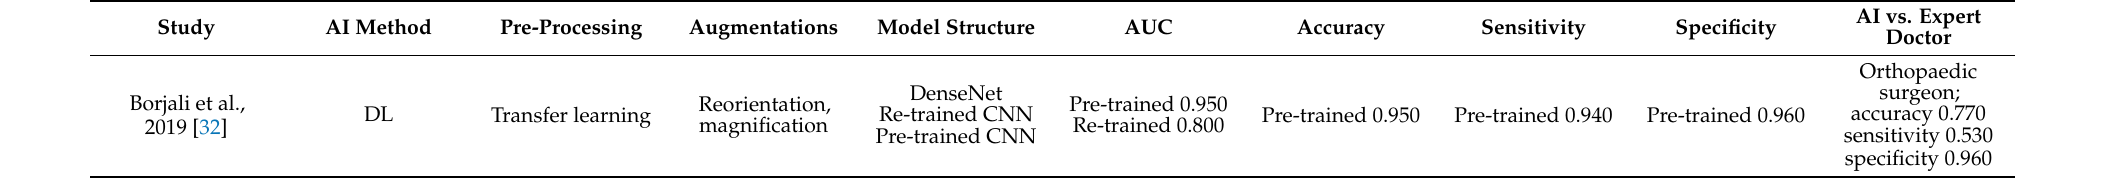
Table 2. Artificial intelligence-based prediction model characteristics described in included